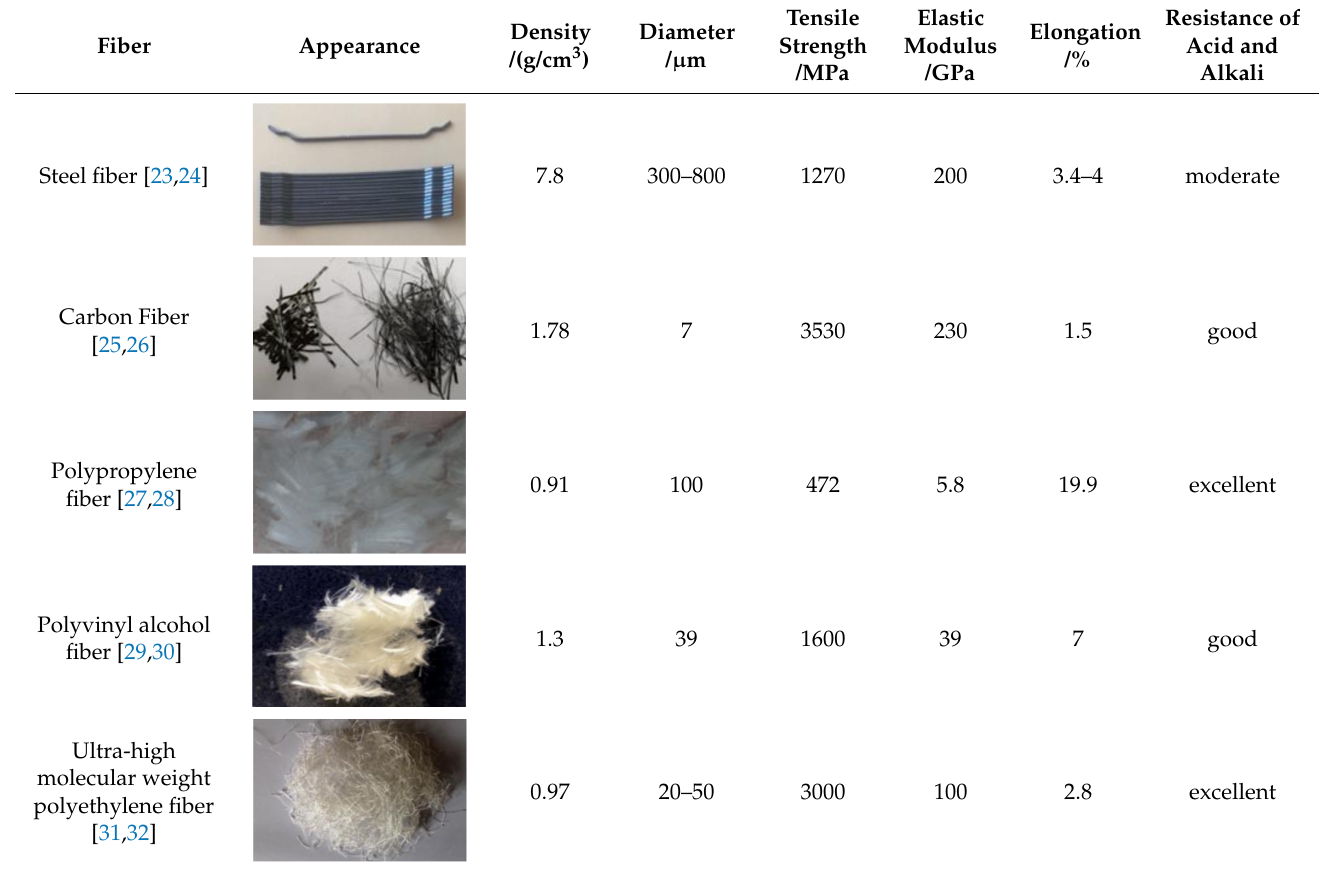
Table 1. Physical indexes and mechanical properties of different